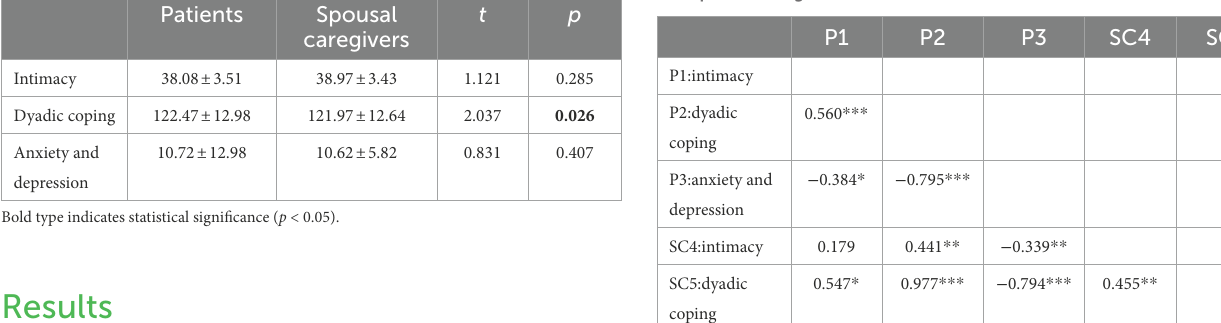
TABLE 3 Correlations of the variables between pancreatic cancer patients and spousal